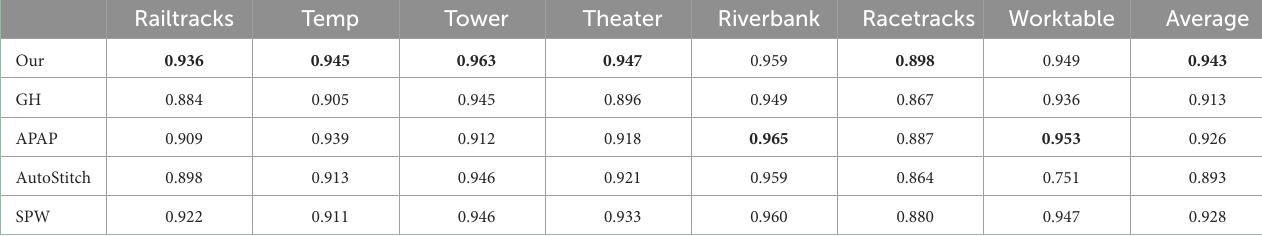
TABLE 1 Comparison of the SSIM of different scenes (the global homography is abbreviated as GH). Railtracks Temp Tower Theater Riverbank Racetracks Worktable